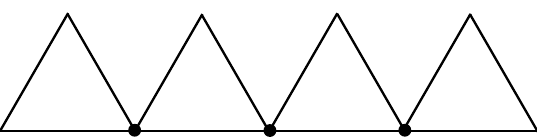
Figure 5. The six-point conformal partial wave in the comb channel, represented as a Feynman diagram. Each line is a particular propagator, 1 =x 2 to some power involving the operator dimen- sions, as speci(cid:12)ed by the de(cid:12)nition of the partial wave, and the three internal points are integrated over. There are six external points which are held (cid:12)xed. The n -point partial wave will look like this (cid:12)gure, but with n 2 (cid:0)